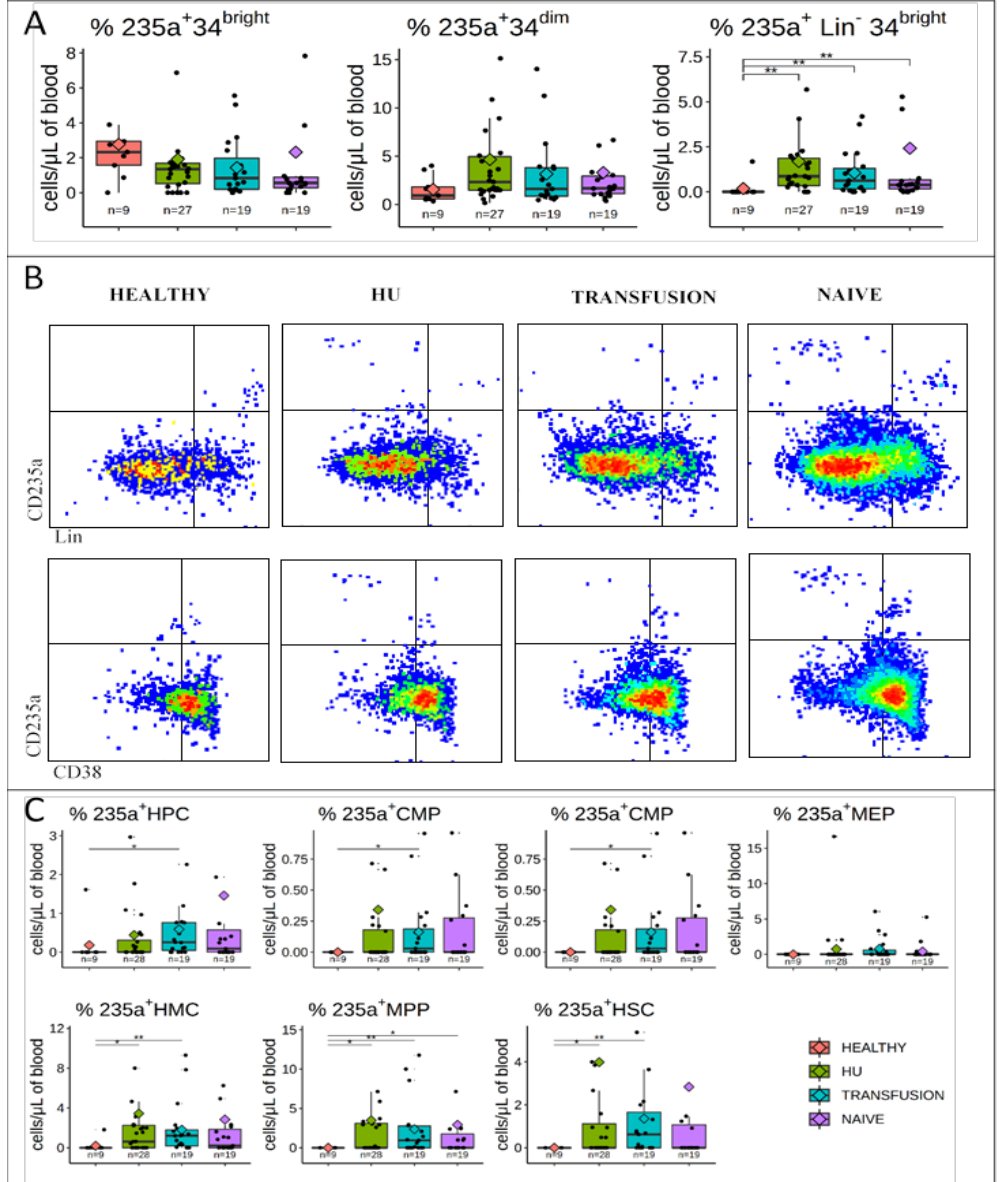
Figure 4. CD235a is over expressed in HMCs, MPPs, and HSCs of SCD patients: ( A ) Boxplots illustrating expression of CD235a on CD34 bright , CD34 dim and lin − CD34 bright cells. Boxplots and significance levels are as in Figure 1. The fraction of cells expressing CD235a is similar in bulk populations of CD34 bright and CD34 dim cells in controls and in SCD patients, but is much higher on the lin − 34 bright cells of the SCD patients. ( B ) Concatenated dot plots illustrating expression of CD235a as a function of lineage antigens and CD38 expression. ( C ) Boxplots summarizing the percentages of HSPCs expressing CD235a. CD235a is expressed in a significantly higher fraction of HMCs, MPPs, and HSCs in SCD patients than in controls. 49f expressing cells and LMPP could not be analyzed for 235a expression due to the low frequency of these populations. * p ≤ 0.05; ** p ≤